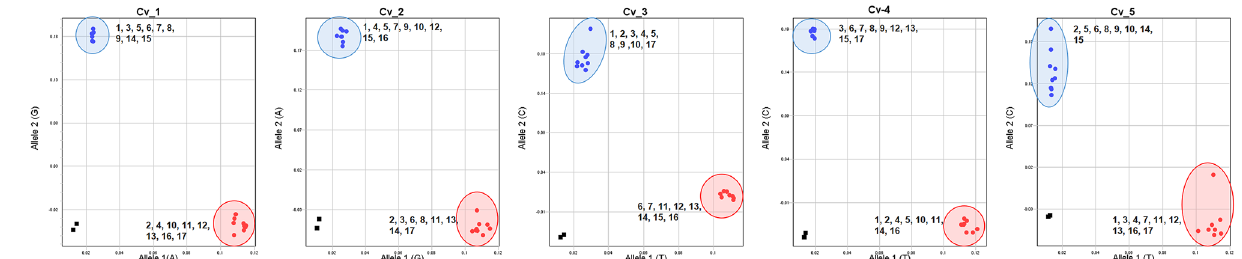
Figure 7. Validation of KASP marker and identification of 17 Korean peanut genotypes based on newly designed KASP markers. Results were visualized based on fluorescence signals emitted by the marker